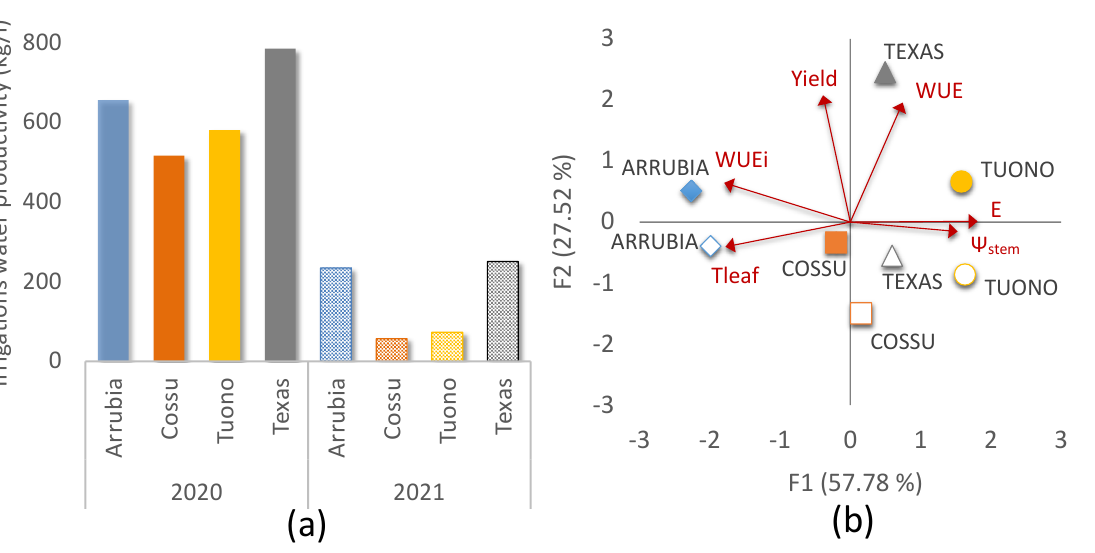
Figure 7. Irrigation water productivity in the four almond cultivar during the two years of study ( a ); PCA biplot showing the distribution, strength, and relationship among cultivar and physiological variables characterizing plant and leaf water status, temperature, and water use efficiency during the study period ( b ). Full and dotted symbols represent, respectively, 2020 and 2021